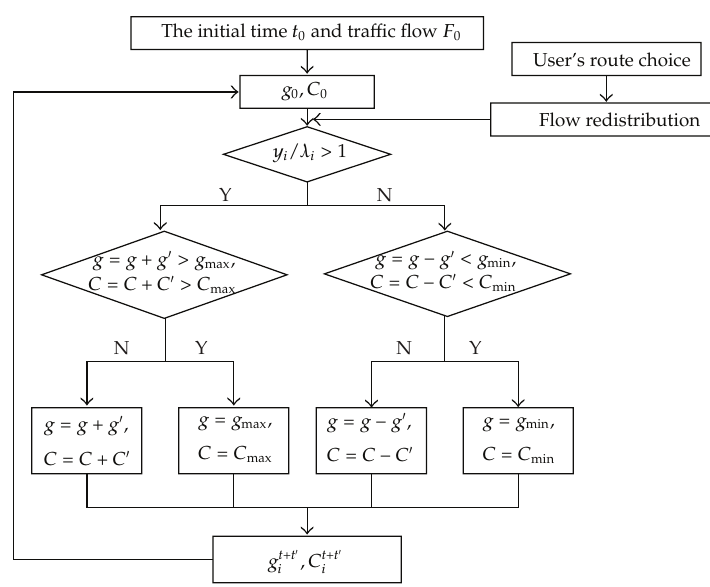
Figure 2: Signal control method under the impact of changing